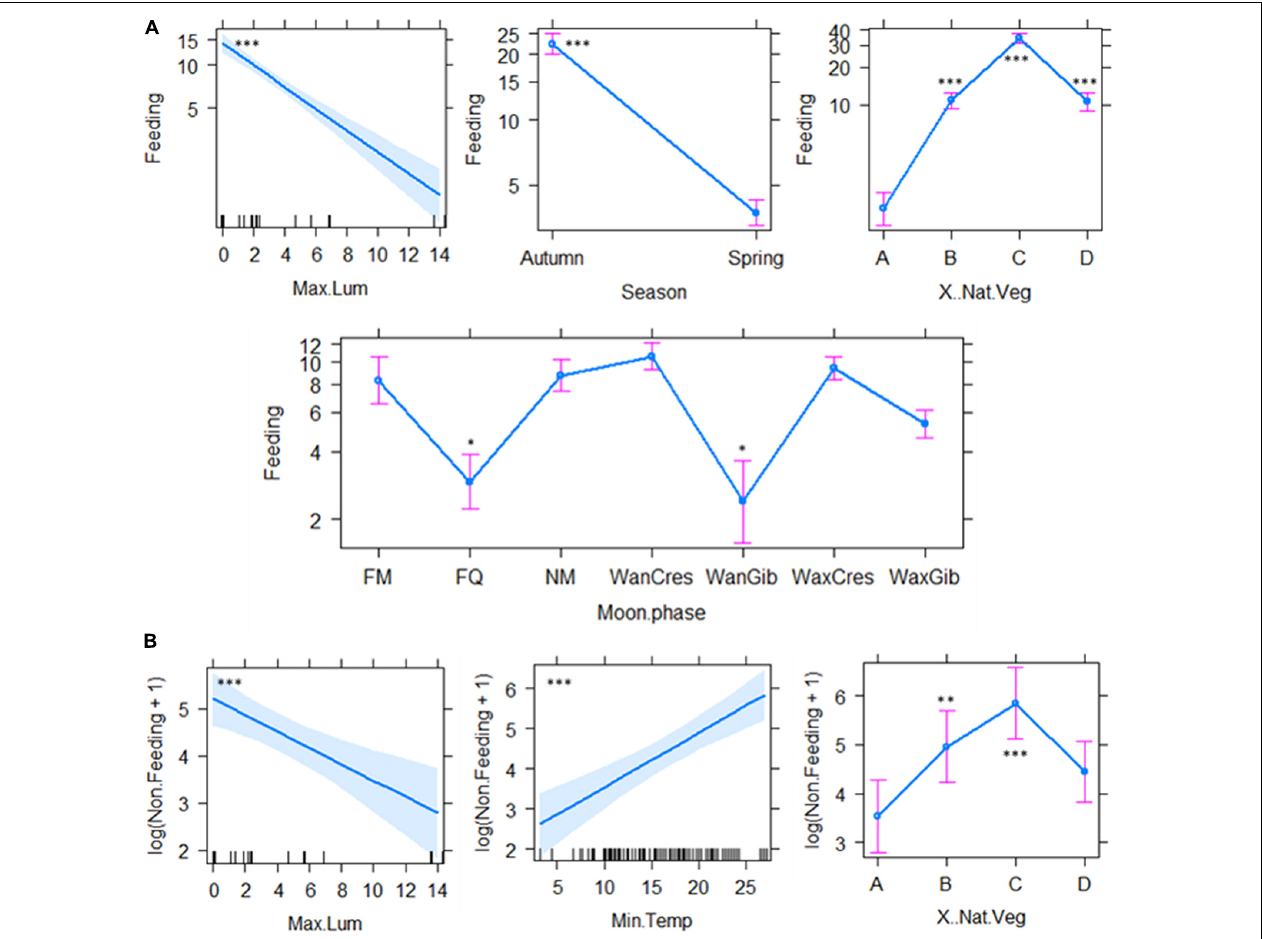
FIGURE 5 | The factors to best explain the observed patterns of feeding (A) and non-feeding (B) activity. Bat detector and date were set as the random factors. A = 0%, B = 25%, C = 50%, D = 100%. FM, full moon; FQ, first quarter; NM, new moon; WanCres, waning crescent; WanGib, waning gibbous; WaxCres, waxing crescent; WaxGib, waxing gibbous. NS, Not Significant. * P < 0.05, ** P < 0.01, *** P <